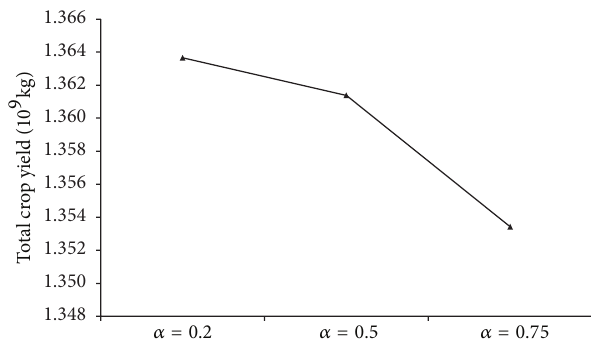
Figure 9: Total crop yield of the entire irrigation districts under different 𝛼 -cut levels.